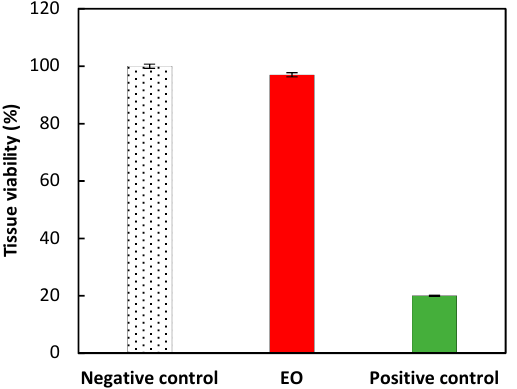
Figure 3. Tissue viability was recorded from the skin irritation test. Negative control (PBS, 100% viability), EO (97% viability) and positive control (5% SDS, 20% viability). Results are expressed as mean ± standard deviation (triplicate).